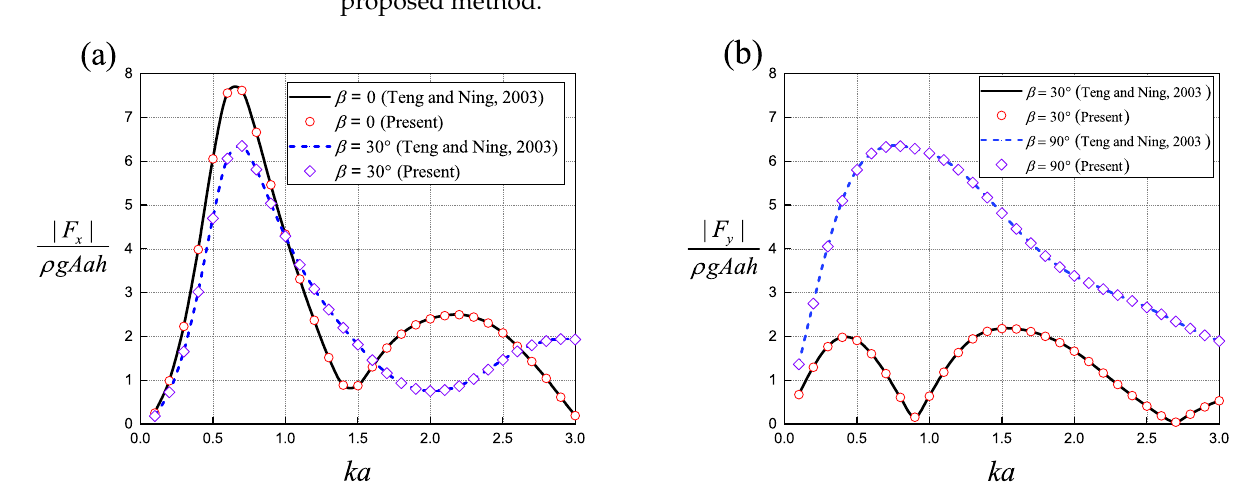
Figure 3. Comparison of the maximum hydrodynamic loads on an impermeable cylinder near a wall derived by our method and by Teng and Ning [23] for h / a = 1, G 1 = 0, and e / a = 1: ( a ) x direction, ( b ) y direction ( A is wave amplitude, A = H /2).